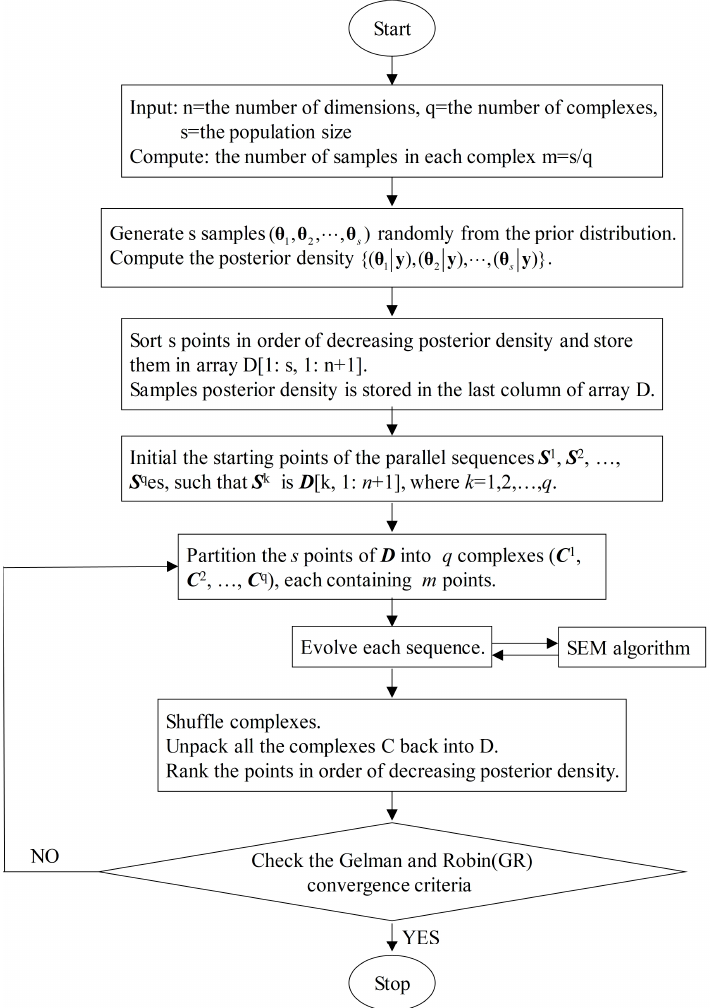
Figure 1. The flowchart of the algorithm.